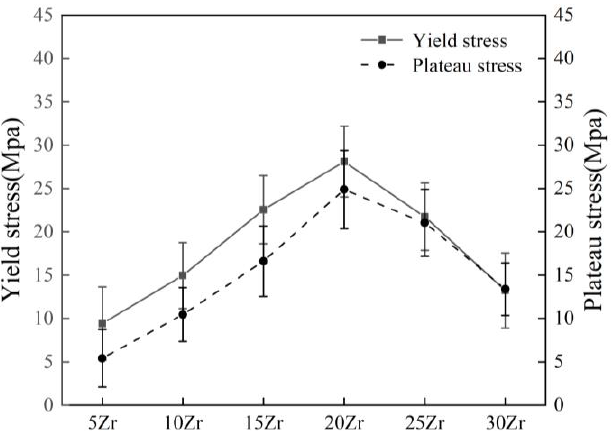
Figure 9. The yield stress and plateau stress of composites with different Zr contents.